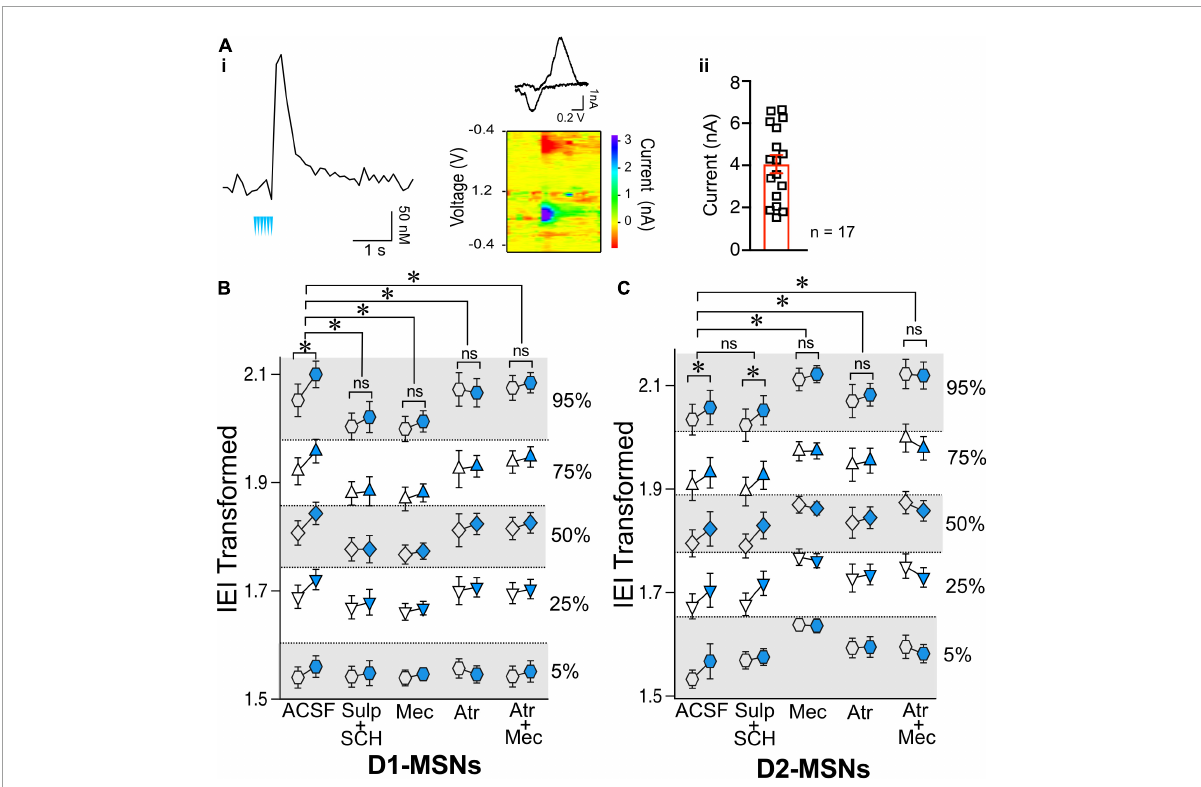
FIGURE4 Effects of ChIs on D1- and D2-MSNs glutamate release are mediated through different pathways. (A) Optogenetic activation of ChIs evokes dopamine release in NAc as measured by voltammetry. (i) Representative DA trace and cyclic voltammogram showing characteristic DA waveform. (ii) DA responses evoked from ChI stimulation scatter plot and average ± SEM showing the range of DA currents from 6 slices and 17 recordings. (B) Transformed IEI of D1-MSNs sEPSCs shown as percentiles of cumulative distribution. Data for the control group (ACSF) is reproduced from Figure 2G . IEI is shown before (Pre, white circles) and after (Post, blue circles) ChIs stimulation in control conditions (ACSF) and in presence of antagonists: Sul + SCH (5 uM SCH-23390, D1 receptor antagonist + 1 uM sulpiride, D2 receptor antagonist), Atr (1